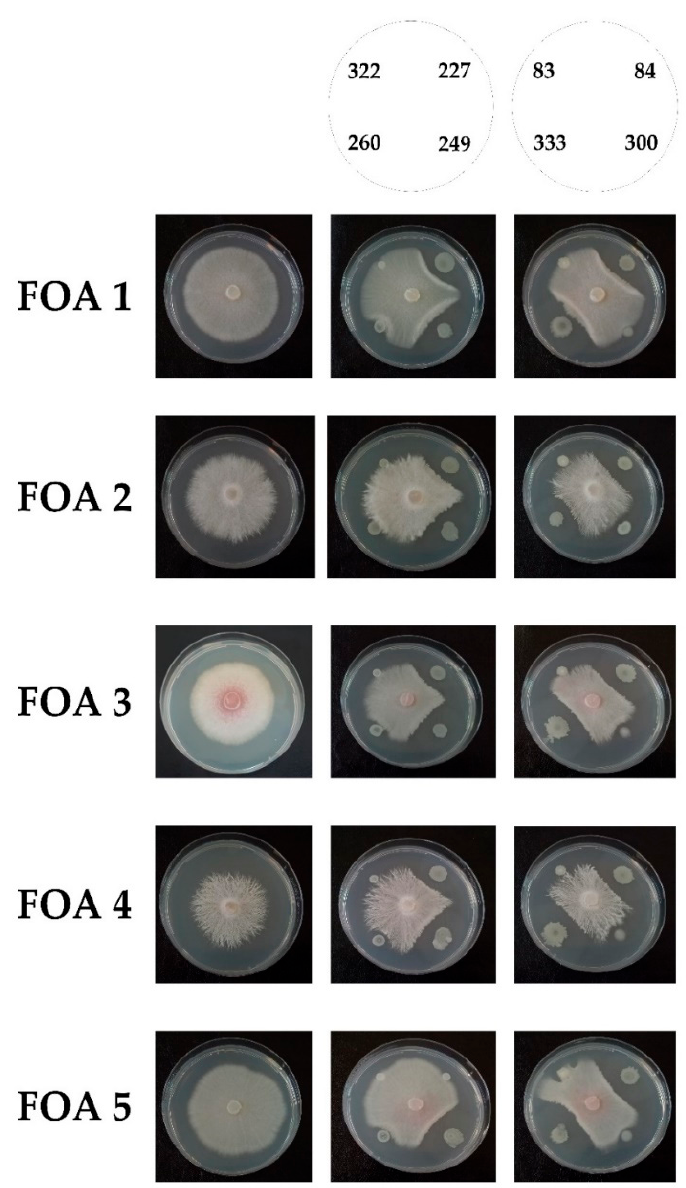
Figure 4. The in vitro comparison test of the antifungal activity of bacterial strains against the dif- ferent strains of FOA (FOA1, FOA2, FOA3, FOA4, and